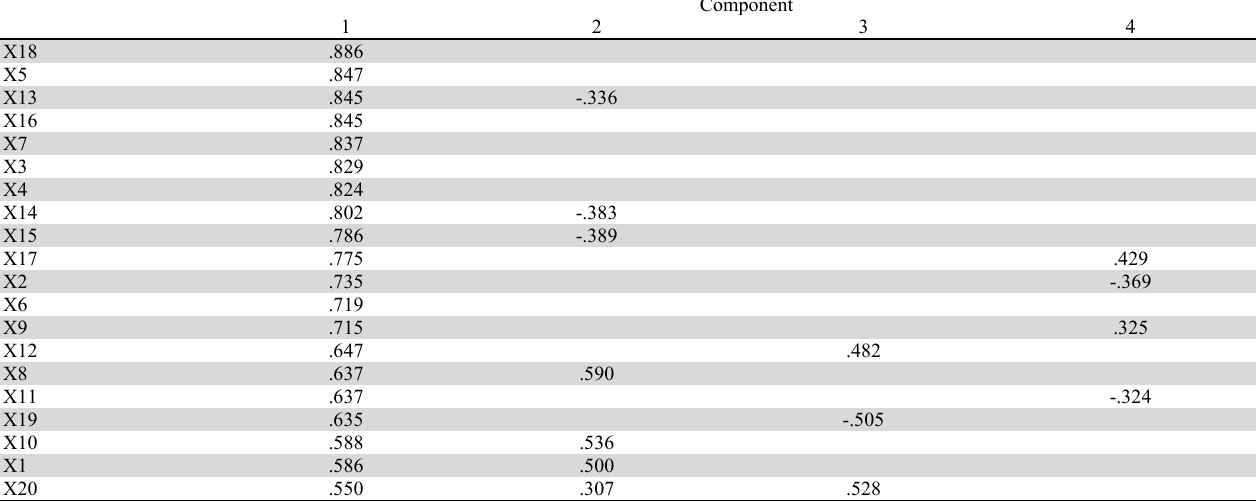
Rotated component matrix